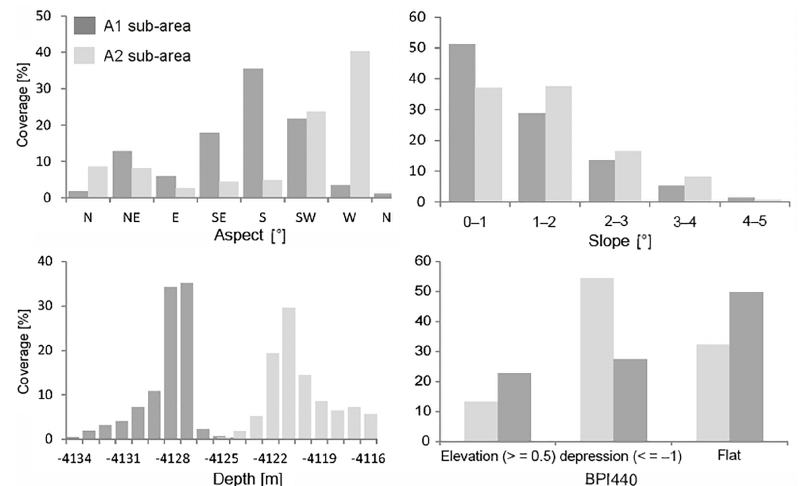
Figure 8. Distribution of derivative values in sub-areas A1 and